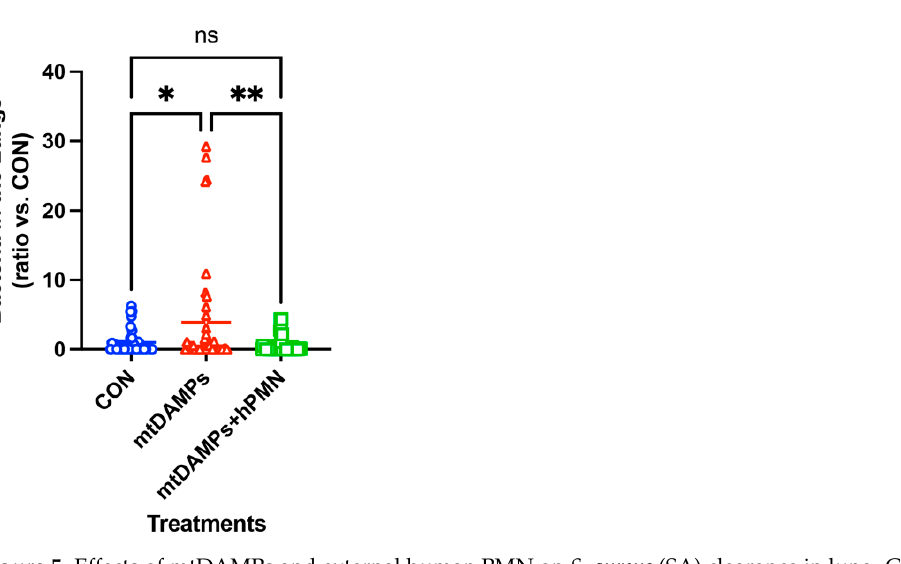
Figure 5. Effects of mtDAMPs and external human PMN on S. aureus (SA) clearance in lung. C57BL6 mice were separated into three groups. Protocols are similar to Figure 1. 1 . CON: Saline i.p. injection